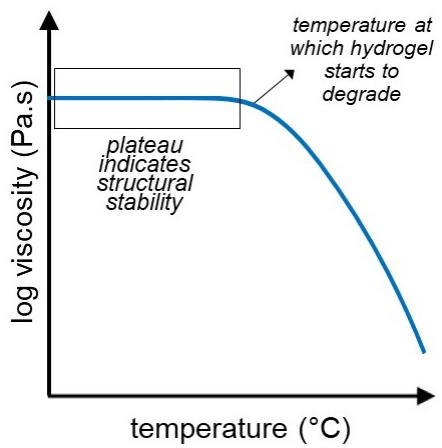
Figure 6. Temperature sweep experiments are a way to monitor the thermal stability of hydrogels. The point at which the viscosity drops suggests the temperature above which the hydrogel starts to degrade or de-crosslink.